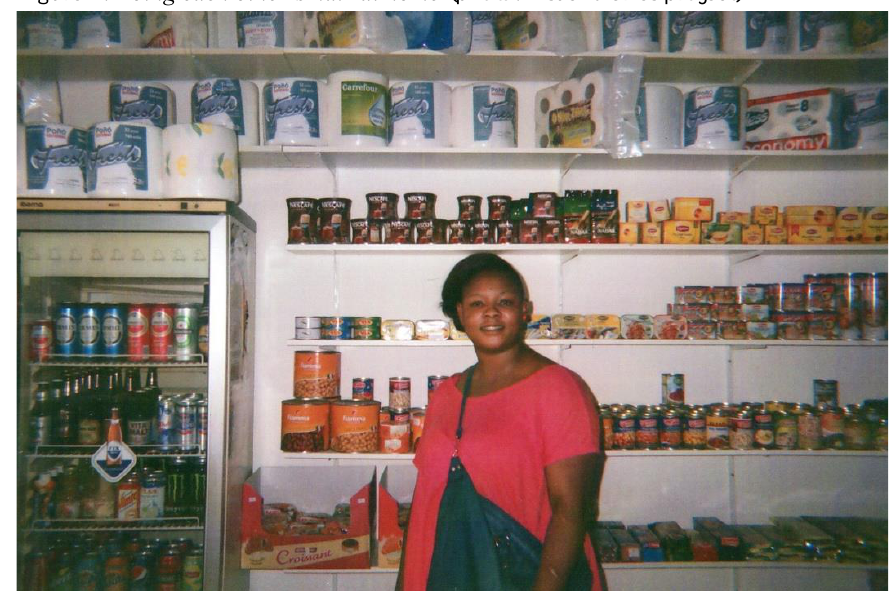
Figure 3: Food shopping in downtown Athens (photo: visual diaries